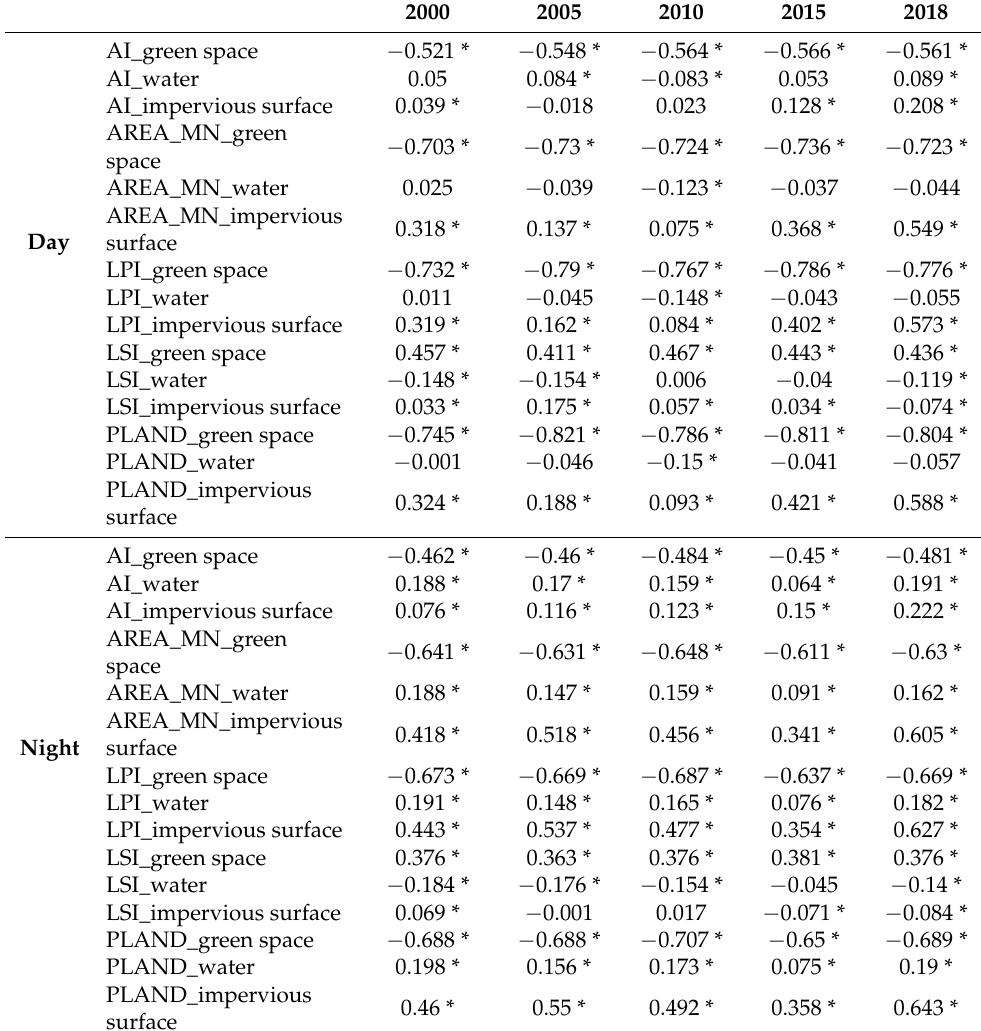
Table 1. Coefficients from the correlation analysis, with the AI, LPI, LSI, AREA_MN, and PLAND values of different land types as the predictors and LST_day/LST_night ratio as the response variable. Note: * represents p <